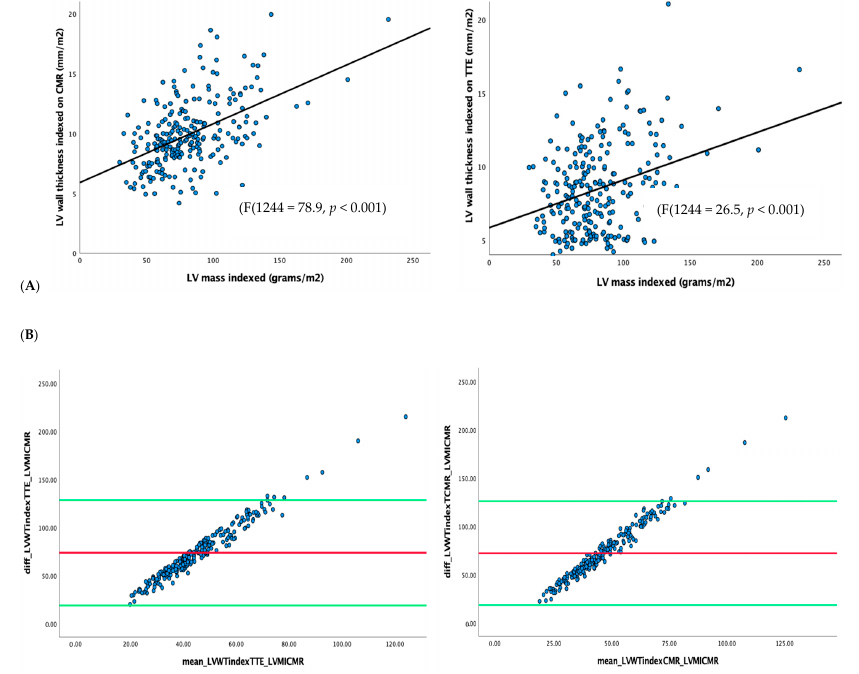
Figure 4. Correlation between LV mass measured from CMR and LV maximum thickness derived from CMR (Panel ( A )) and TTE (Panel ( B )). Bland–Altman plot: ( A ): mean = 73.5, 95% CI = 18.7–128.2, p < 0.001. ( B ): mean = 72.0, 95% CI = 18.3–125.8, p < 0.001.